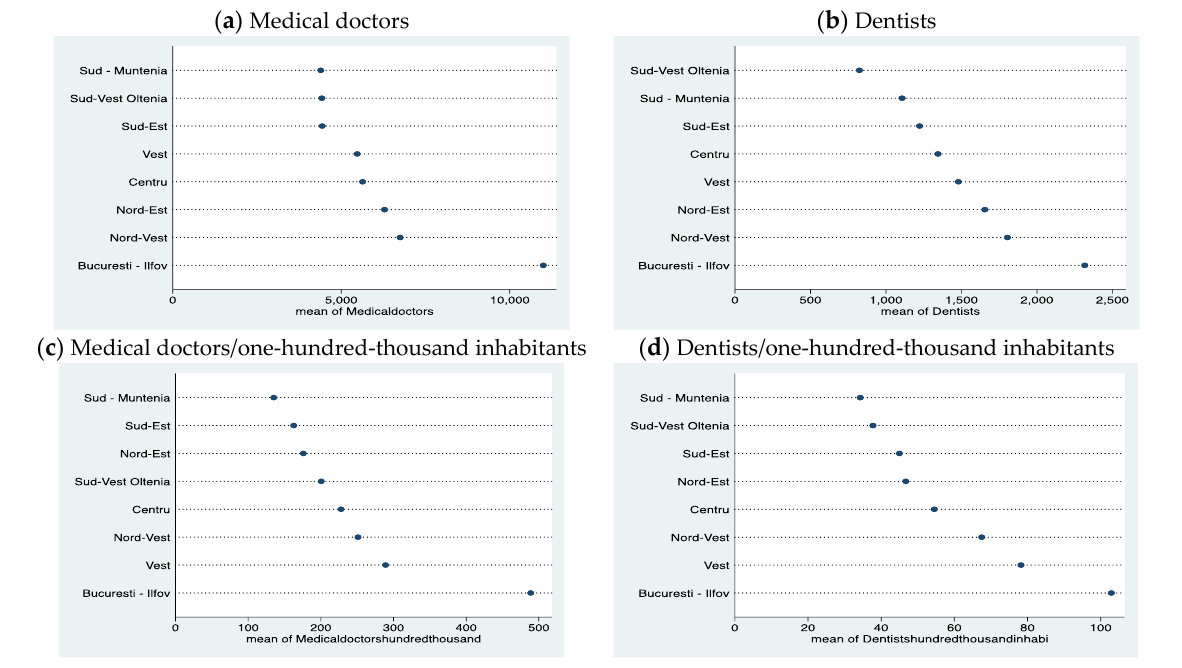
Figure 4. Number of doctors in Romanian Regions. Source: computed by the authors based on the Eurostat database [23] using Stata 15.1.